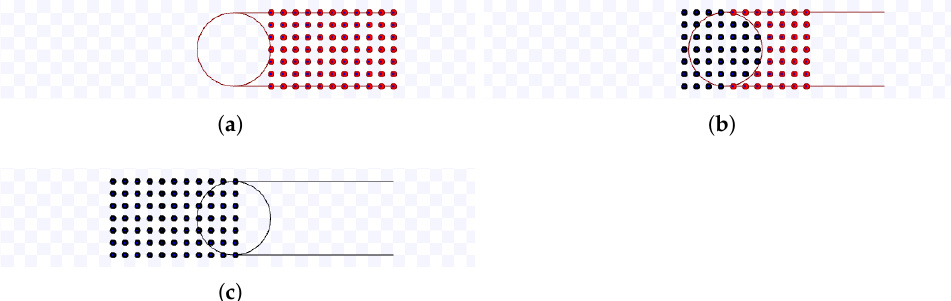
Figure 23. Simulation on Stage for parallel lanes strategy using s = 3 m, d = 1 m during T = 13 s. Available on https://youtu.be/2Y1RHc9YVaw, accessed on 12 June 2022. ( a ) 0 s: beginning of the simulation; ( b ) After 6.5 s; ( c ) 13 s: ending of the